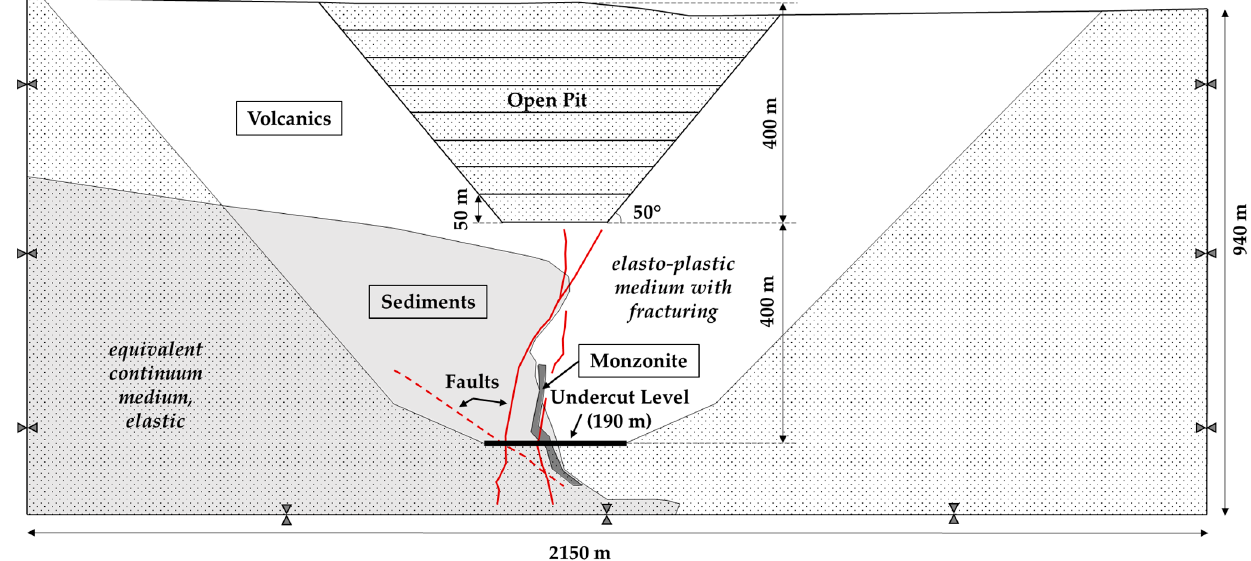
Figure 10. FDEM geometry and boundary conditions for model No. 1–5. Note removal of the fault, represented by dashed line, in model No. 4 and 5. Pit removed for model No. 9. Dotted regions indicate elastic material, while solid regions are modelled as elastoplastic regions with fracturing. Grey shaded regions comprise the sediments, and white regions are within the volcanics geotechnical domain.